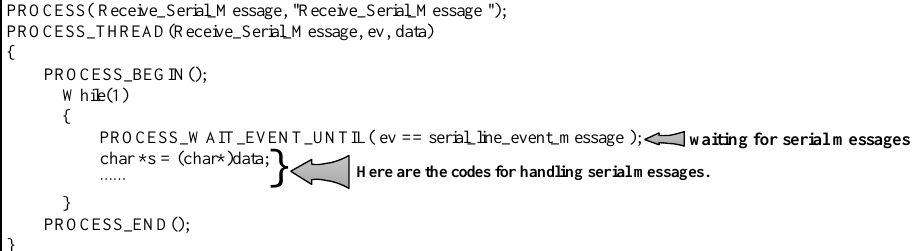
} Here are the codes for handling serial messages. Figure 9. An example of the Contiki process.